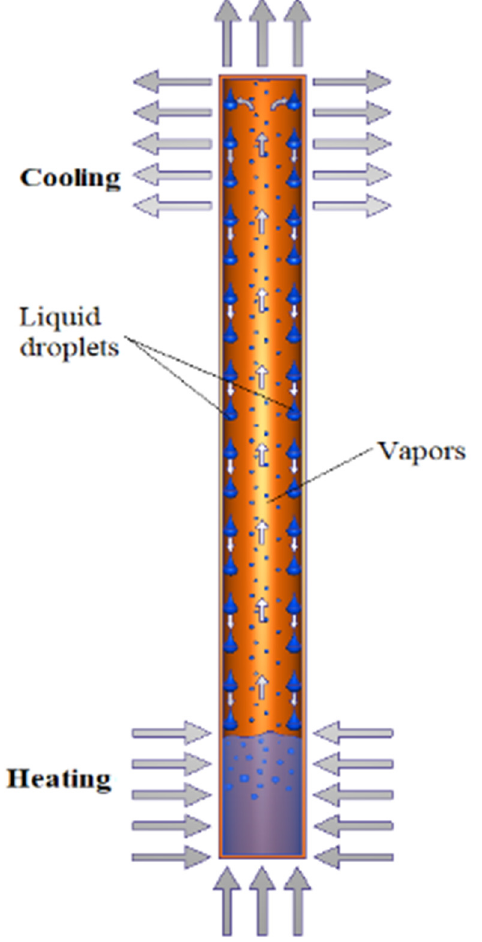
Figure 1. The operating principle of heat pipes.